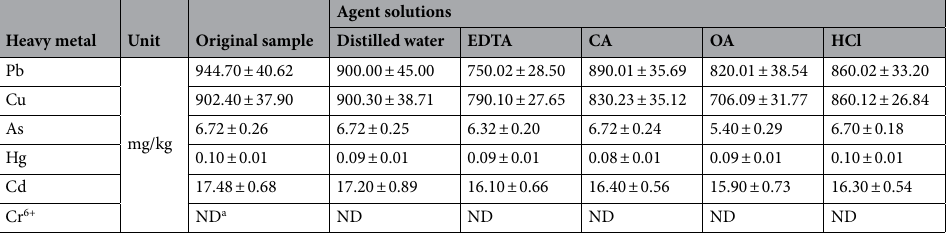
Table 3. Comparison of heavy metal contents before and after treatment using various agent solutions. a Not detected.